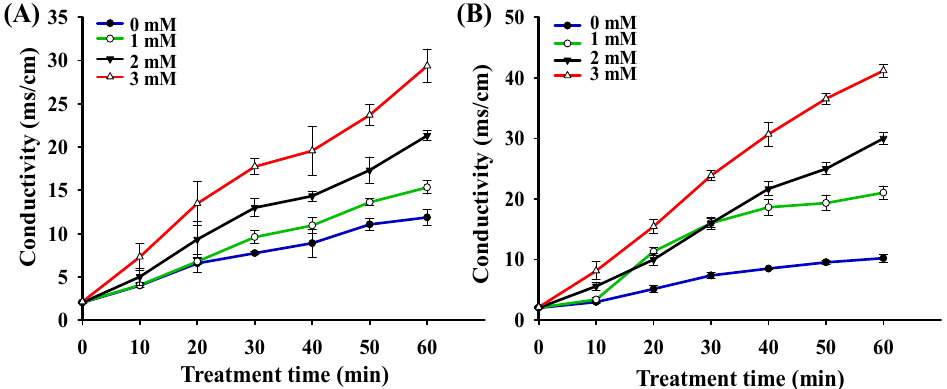
Figure 3. Transmission electron micrographs of Pediococcus pentosaceus R1 and Lactobacillus fermentum R6 incubated in MRS broth with different H 2 O 2 concentrations for 1 h.